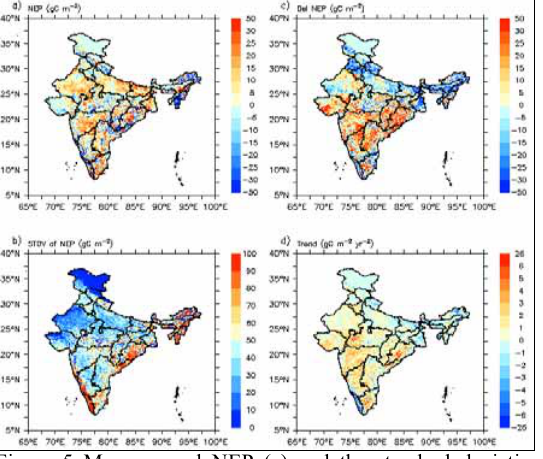
Figure 5 Mean annual NEP (a) and the standard deviation (b) during 1981-2006, c) decadal change of annual NEP during 1981- 1990 and during 1991-2000, d) long-term linear growth rate of NEP over India during 1981-2006.